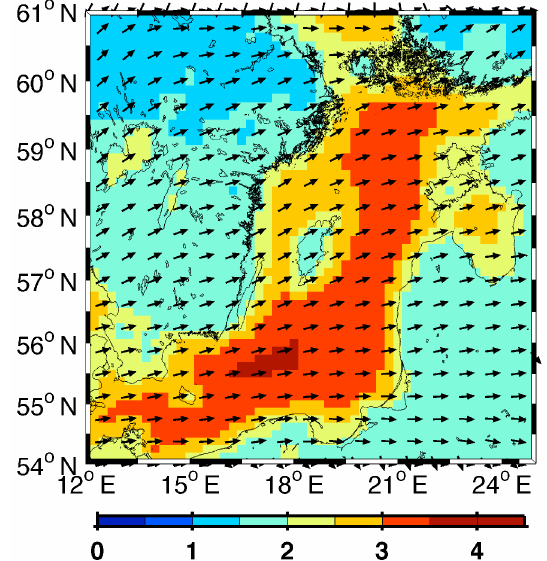
Figure 5. July climatology of the 10m winds driving the simula- tions. The calculation is based on 1989–1993 3-hourly snapshots of RCA3 (Sect. 2.1). The arrows show the direction of the winds. The colour denotes the speed in units ms − 1